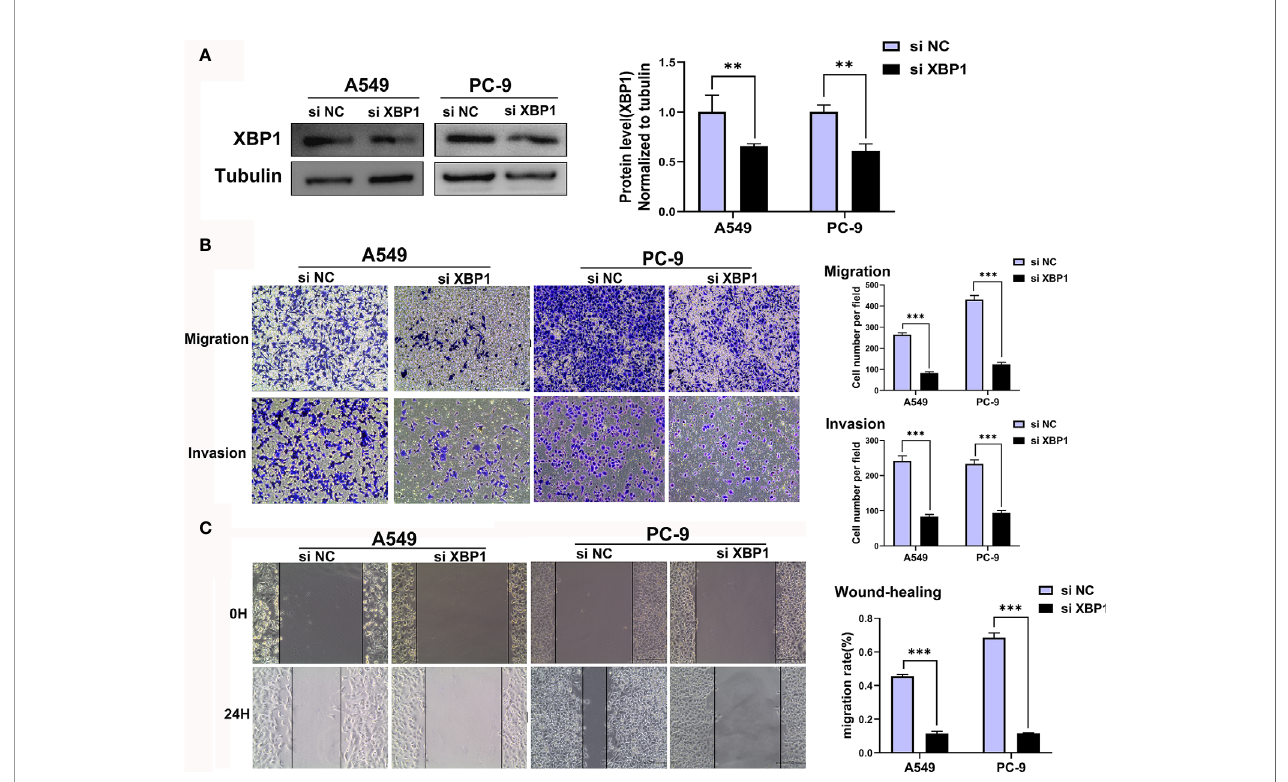
FIGURE 3 | Downregulated XBP1 expression inhibits lung cancer cells ’ migration and invasion. (A) Western blot assay showed the expression of XBP1 in A549 and PC-9 transfected with si-XBP1 and negative control. (B) Transwell migration and invasion assays of A549 and PC-9 cells transfected with si-XBP1 and negative control. (C) Wound-healing assay of A549 and PC-9 cells transfected with si-XBP1 and negative control. Data were represented as the mean ± SEM of three independent experiments. ** P < 0.01, *** P <